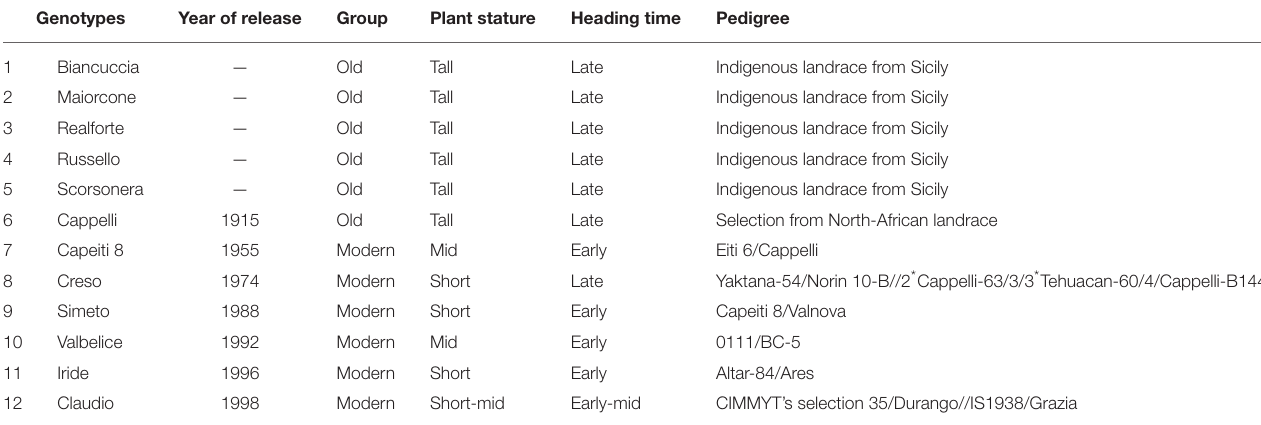
TABLE 1 | Wheat genotypes tested by year of release, pedigree, and some agronomic traits.